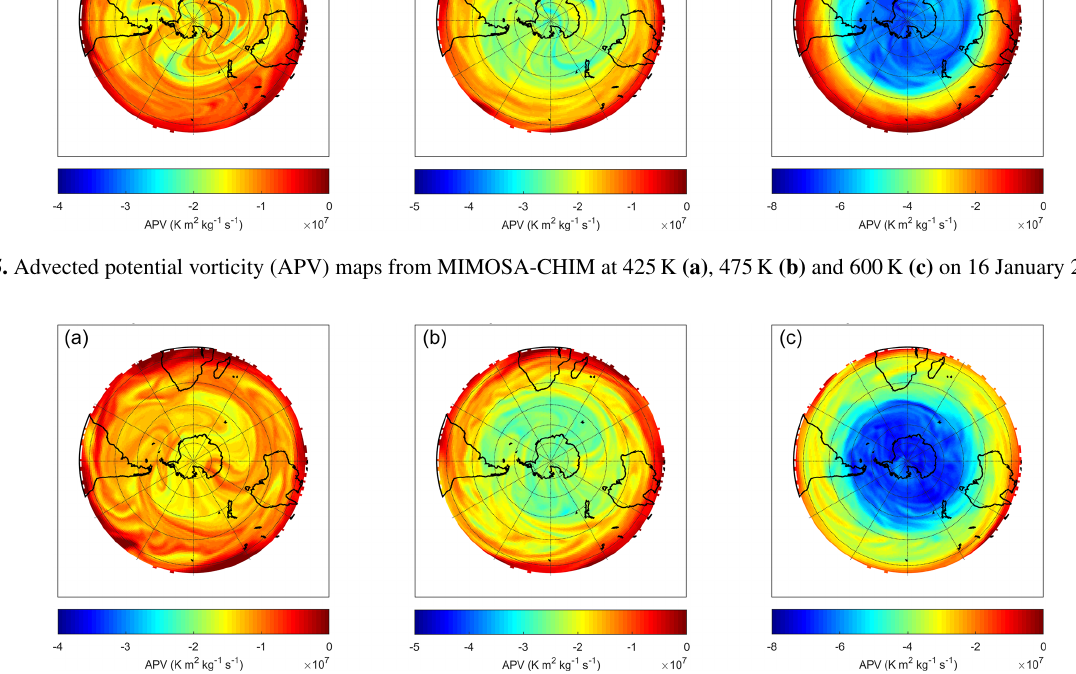
Figure 6. APV maps from MIMOSA-CHIM at 425K (a) , 475K (b) and 600K (c) on 6 February 2009.